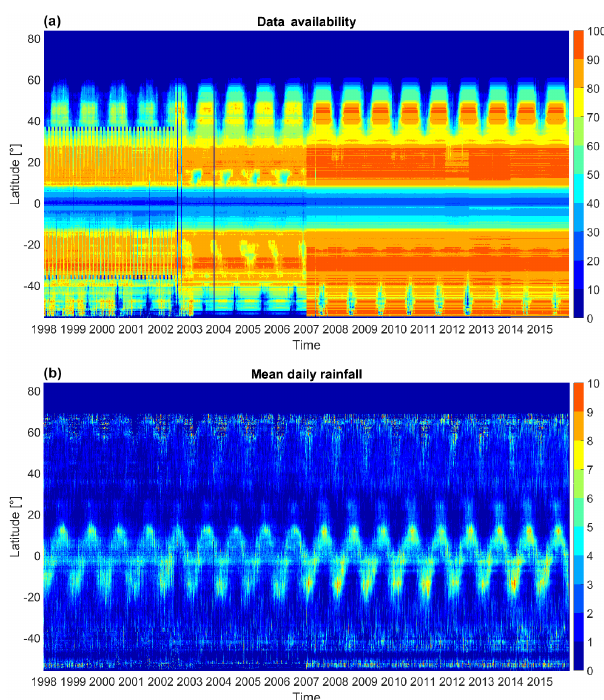
Figure 3. Hovmöller plot showing the spatial–temporal data avail- ability, in percentage of the total annual available data (upper panel) and the mean daily rainfall (in millimeters per day, lower panel) of the SM2RAIN-CCI rainfall data set for different latitude